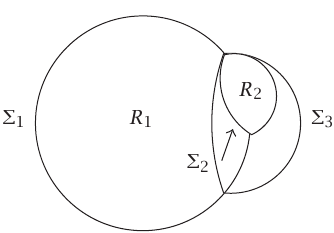
Figure 2.3 . Increasing the curvature of Σ Σ 1 fixed increases the curvature of volume of R 2